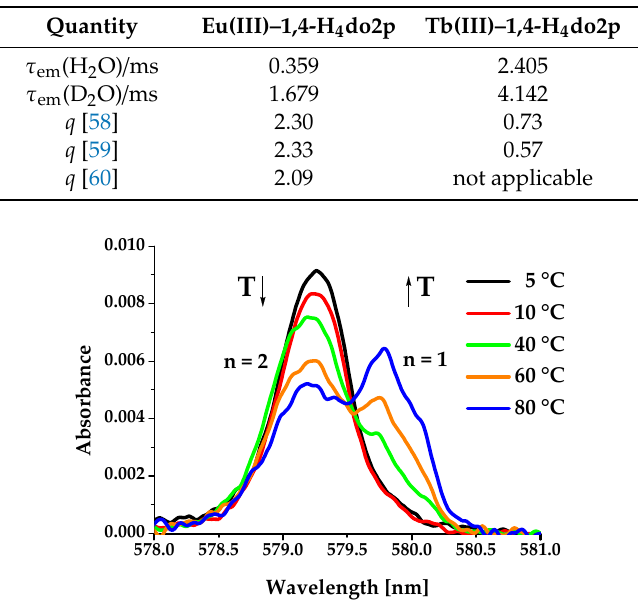
Table 5. Luminescence lifetimes τ em and the corresponding hydration numbers q of the Eu(III) and Tb(III) complexes (pH 8.5, 25 ° C).